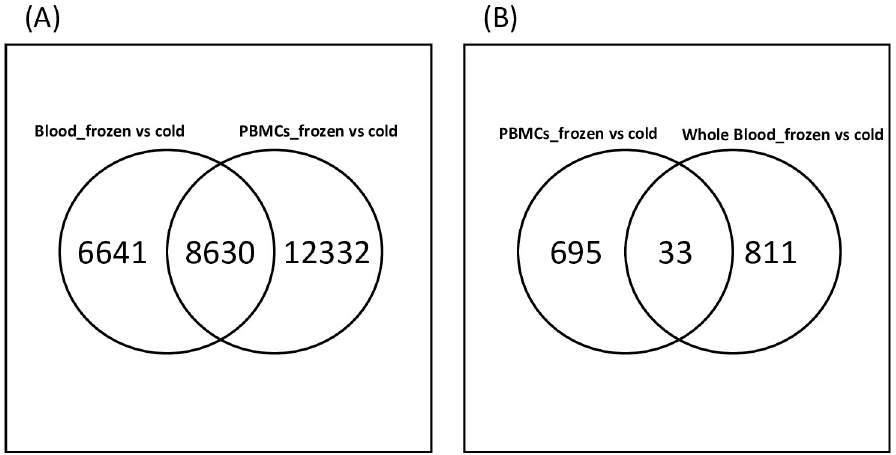
Fig 6. (A) Venn diagram showing the common number of DEGs where comparisons of PBMCs and whole blood are affected by cryopreservation (frozen) vs. cold conditions are done. (B) Venn diagram showing the common DEGs from top 1000 mapped IDs using IPA where comparisons of PBMCs and whole blood are affected by cryopreservation (frozen) vs. cold conditions.